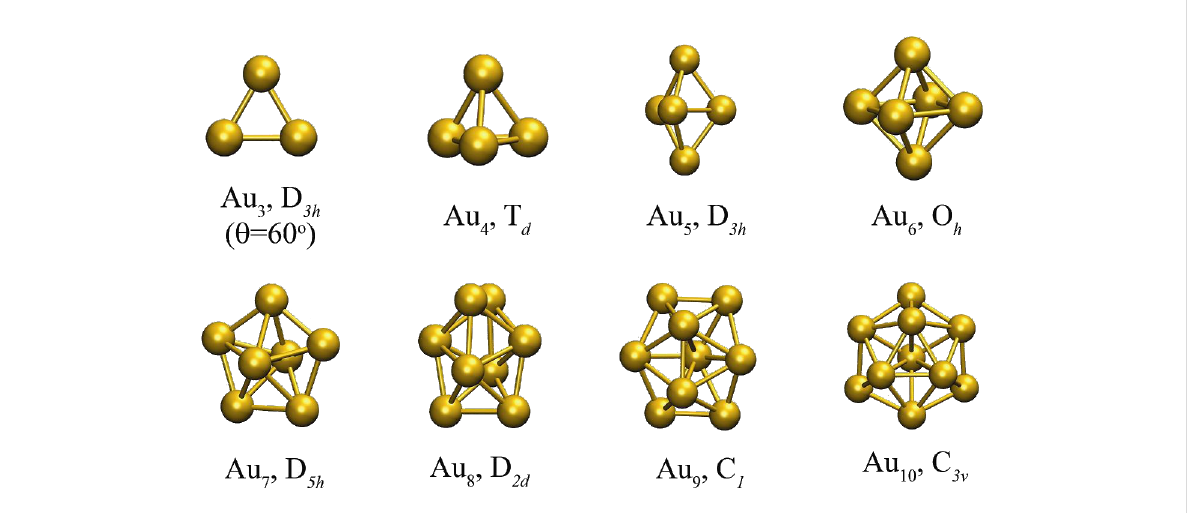
Figure 9: Global minimum energy structures for Au 3 –Au 10 clusters obtained for empirical potentials, along with their symmetry point group.